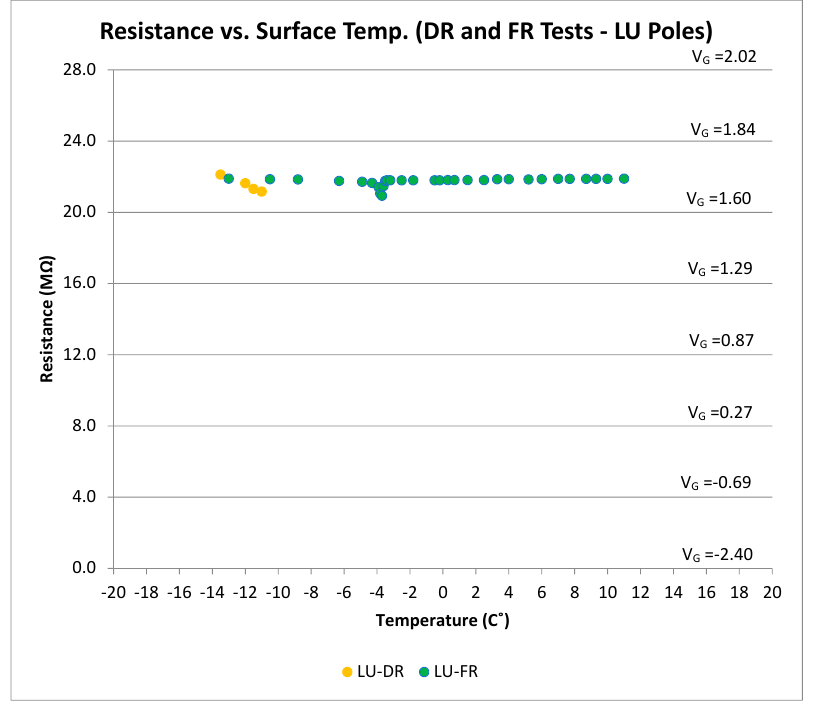
Figure 10. Resistance (and voltage) versus surface temperature for all FR tests (LUS Poles). Sensors 2017 , 17 , 2912